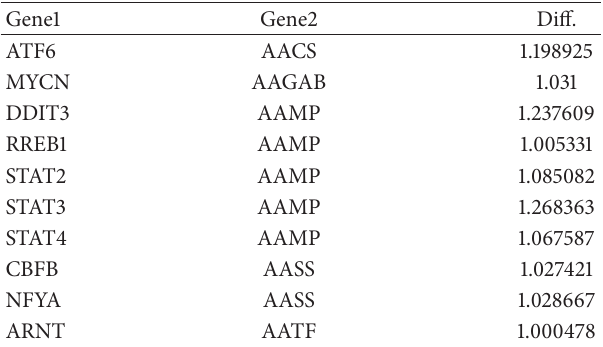
Table 1: Some differentially coexpressed gene